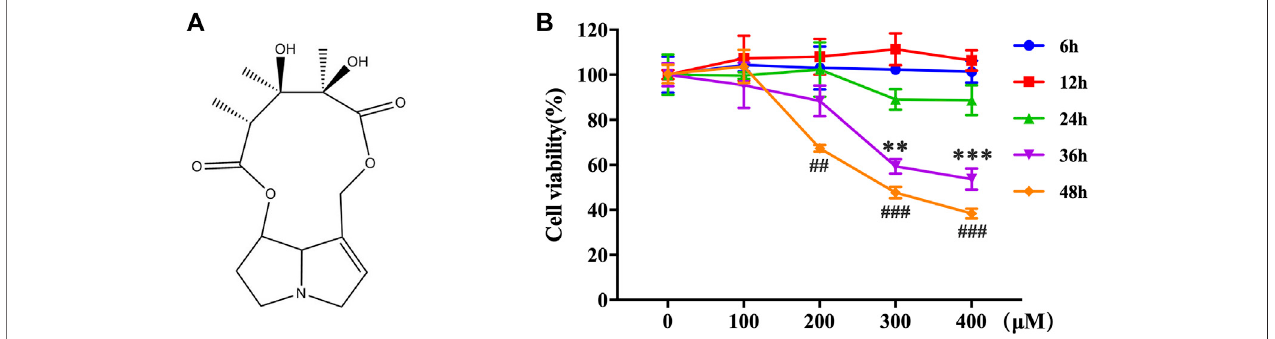
FIGURE 1 | MCT decreased the cell viability in primary rat hepatocytes. (A) The chemical structure of MCT. (B) Cell viability was measured by CCK-8 assay. The hepatocytes weretreatedwith different doses ofMCT(100, 200,300, and 400 μ M) for differenttimes(6, 12, 24,36, and 48 h). The results arerepresented inthe wayof mean ± SDerrorofthreeindependentexperiments. ** p < 0.01and *** p < 0.001compared tothecontrolofthe300 μ Mgroup, ## p < 0.01and ### p < 0.001comparedto the control of the 400 μ M